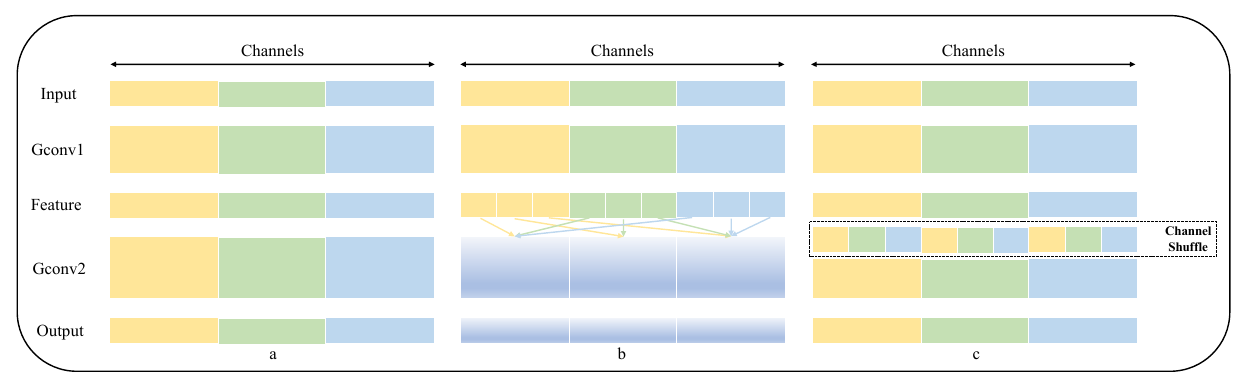
FIGURE 2 | Schematic diagram of the operation of Channel